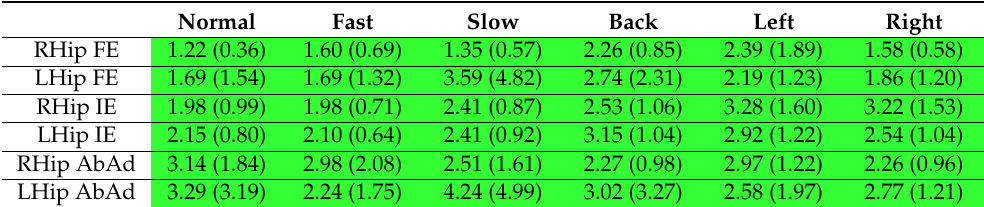
Table 4. Comparisons of range of motion with Cluster Method. Mean (Standard Deviation) of RMS difference (IMU-Clust) in range of motion estimates. All angles in degrees. Green highlights indicate mean values <5 deg. No results reported for knees or ankles because frequent marker occlusion prevented Cluster estimates. Results segmented by type of walking gait; namely normal forward (Normal), fast forward (Fast), slow forward (Slow), backward (Back), lateral left (Left), and lateral right (Right). Joint angles are flexion/extension (FE), internal/external rotation (IE), abduction/adduction (AbAd), dorsiflexion/plantarflexion (DP), and inversion/eversion (InEv). R and L prepended to joint names indicate right and left side, respectively. Minimum of 10 subjects represented per entry. Normal Fast Slow Back Left Right RHip